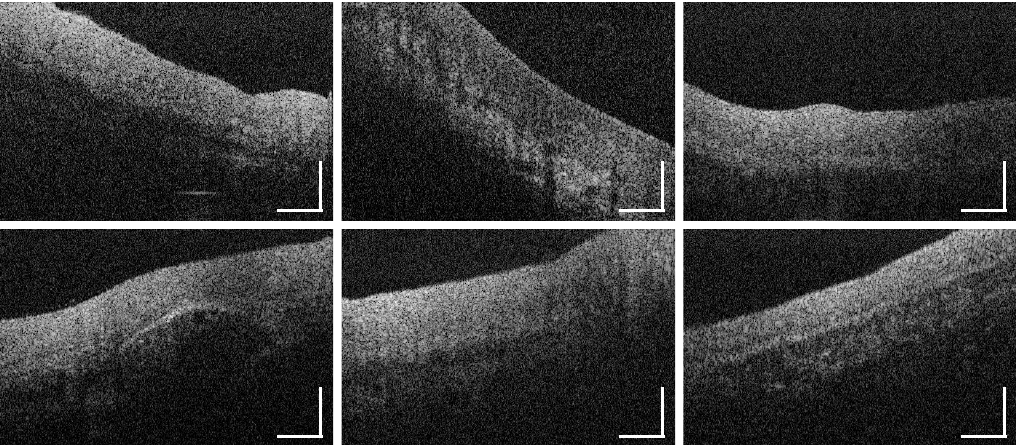
Figure A22. Supplementary intensity-based OCT cross sections of the oral muucosa of the hard palate (MP12, Figure 1). Scale bars: 200 µ